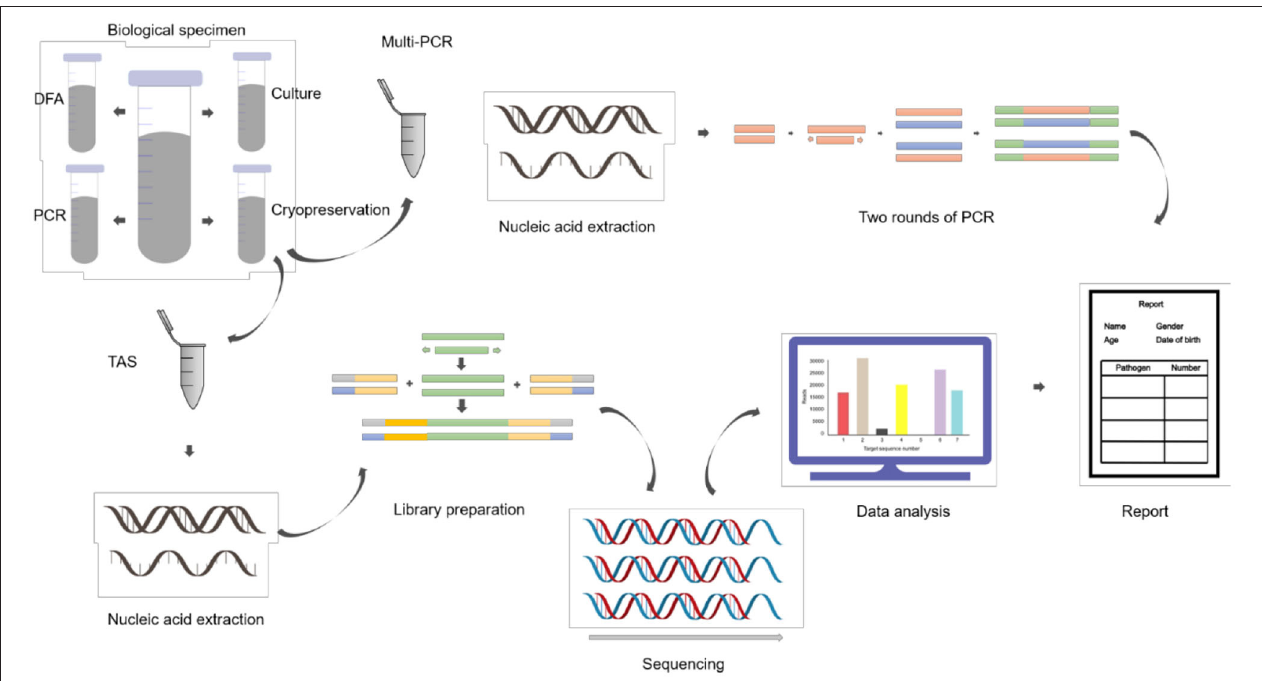
FIGURE 1 | Alveolar lavage fluid (ALF) samples analysis